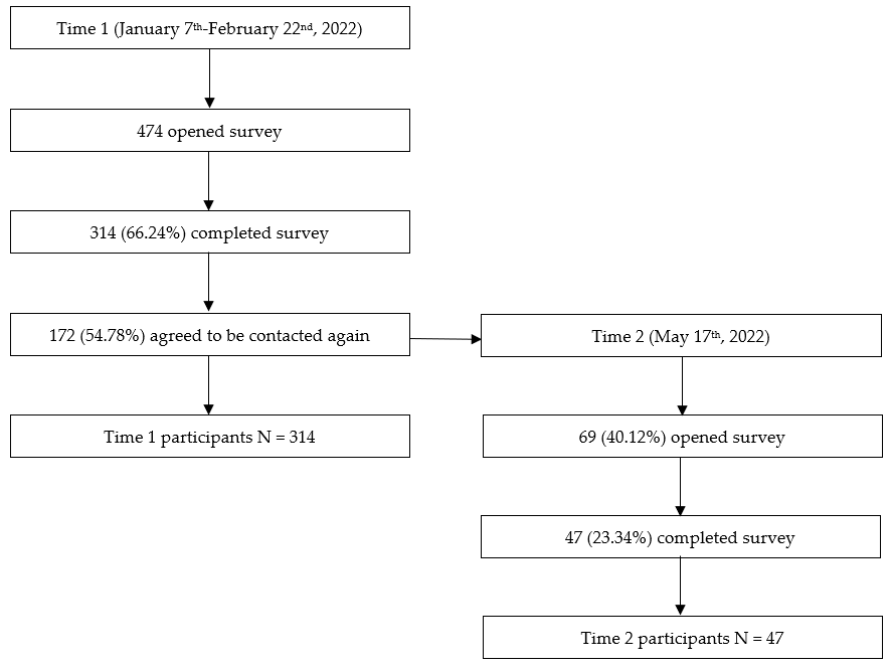
Figure A1. Flowchart for Participant Recruitment.